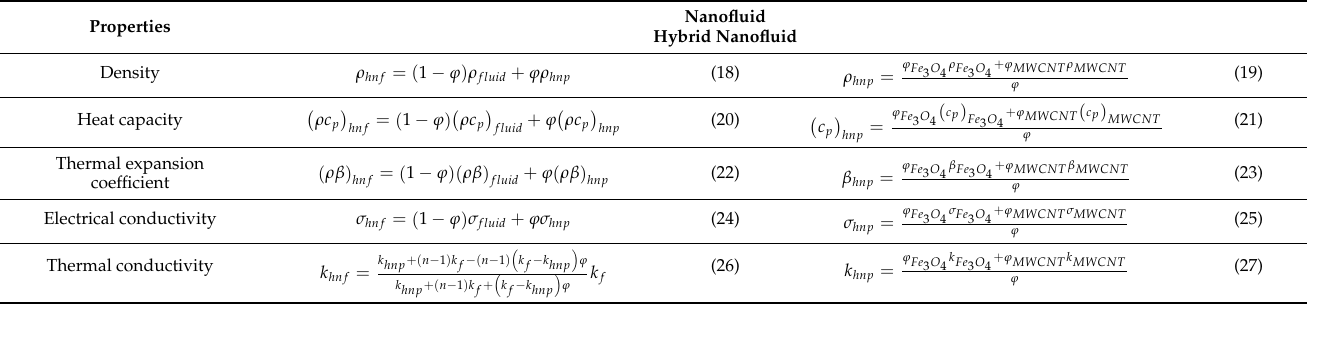
Table 2. The correlations used to estimate the properties of classical and hybrid nanofluids